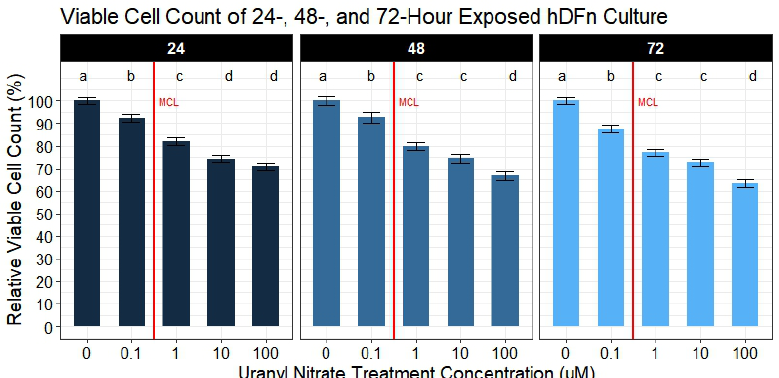
Figure 2. Viable cell count of UN exposed hDFn. Bar charts are faceted by exposure time representing the mean viable cell count percentage ± StdErr of each treatment group (n = 6 done in sextuplicate). All UN concentrations are in µ M with -0- representing control group. At all days UN levels below EPA MCL caused a significant decrease in viable cell count. Statistically significant differences between groups are illustrated by compact letter display with different letters at the top representing a balanced Tukey pairwise t -tests where p -value ≤ 0.05. Group means followed by a common letter were not different at 5% level of significance. Vertical red line illustrates the EPA MCL threshold for uranium (0.126 µ